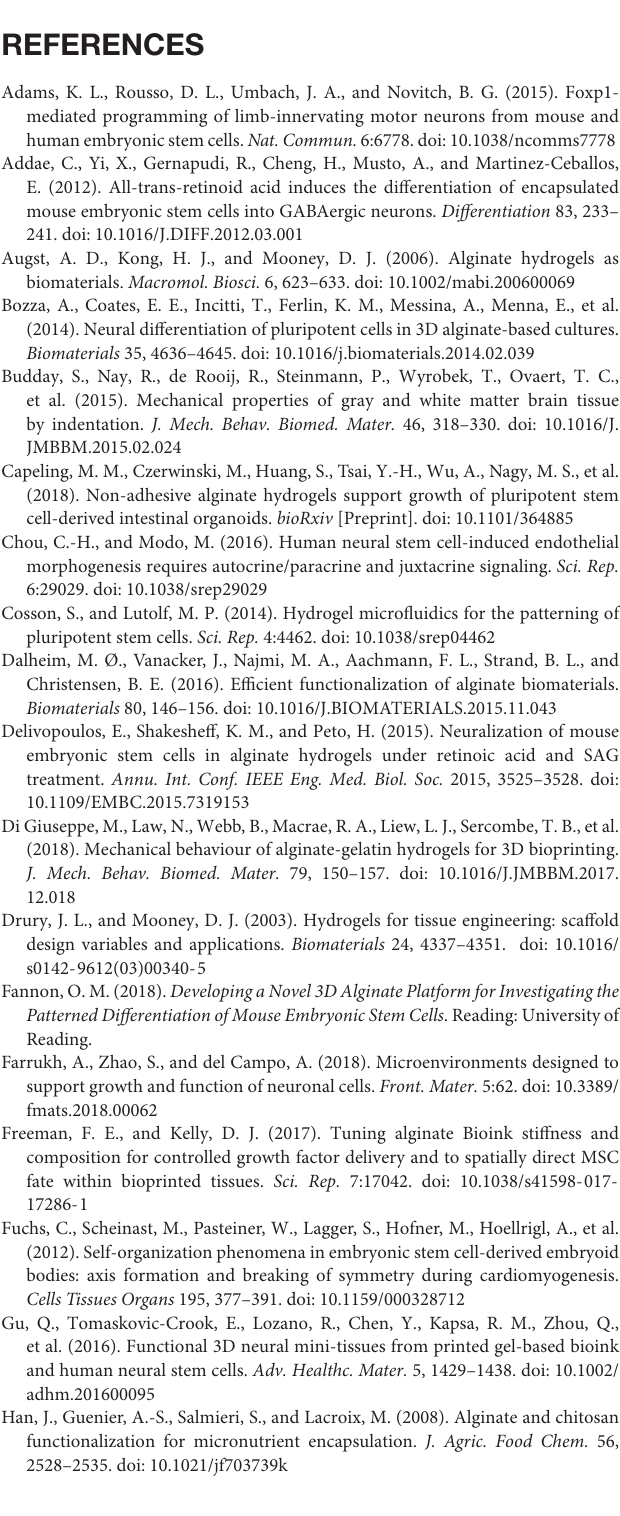
Supplementary Table 3 | Details of primers used for quantitative PCR. Supplementary Table 4 | HGF11-derived MNs produce Raldh2. Supplementary Table 5 | HGF11-derived MNs produce